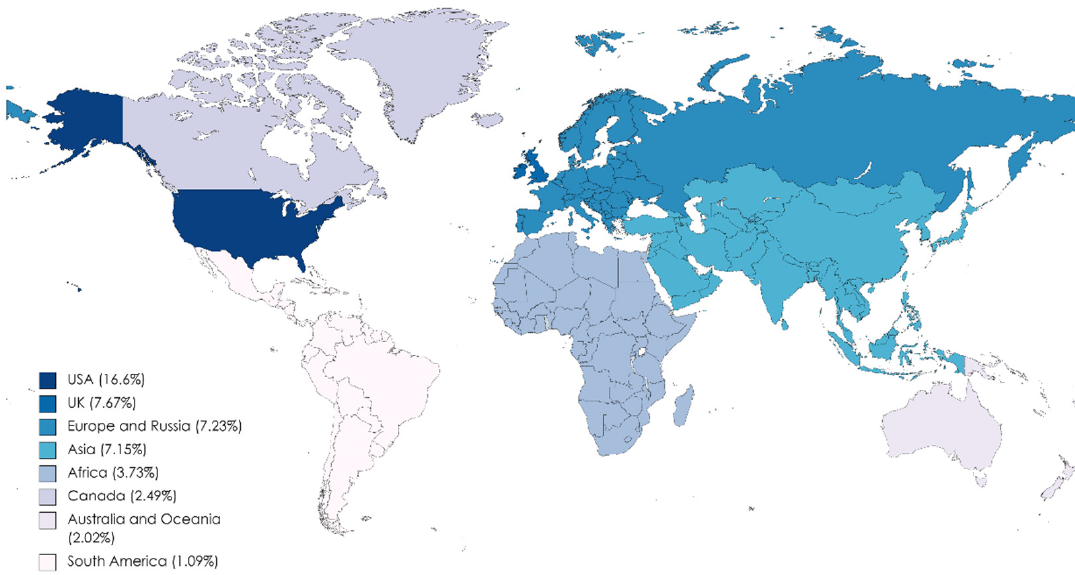
Figure 2. Geographical representation of Twitter activity in period 1 (Source: Own data, created with mapchart.net (accessed on 4 April 2022)).